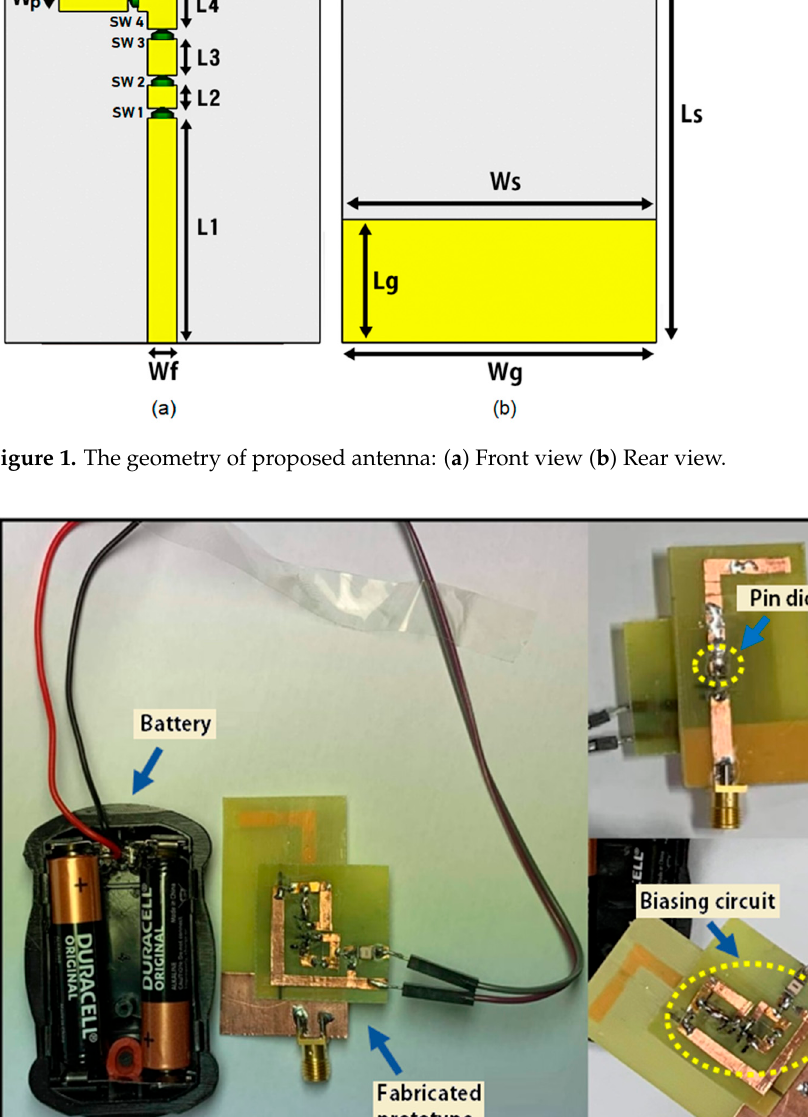
Figure 1. The geometry of proposed antenna: ( a ) Front view ( b ) Rear view. Table 1. Dimensions of proposed antenna.